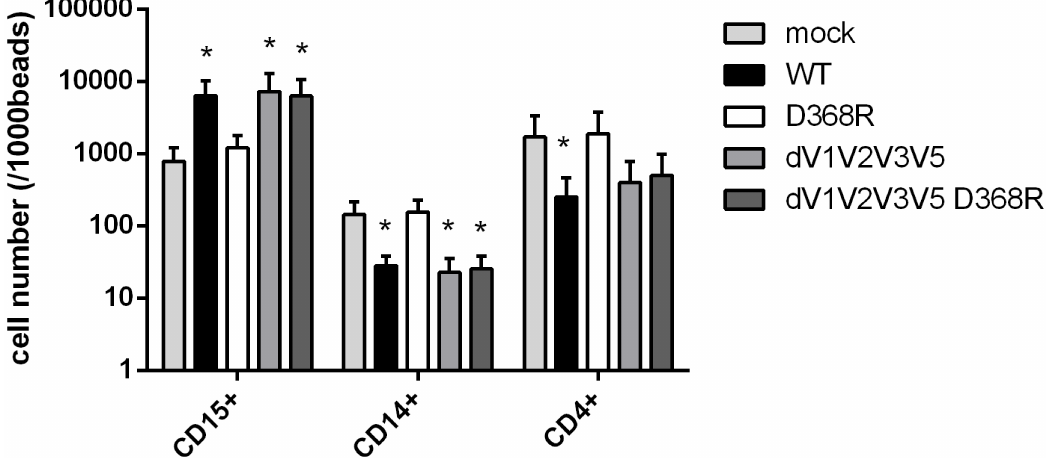
Fig 4. gp120 induces neutrophils and lymphocytes migration but inhibits monocytes migration. Transwell immune cells migrationanalyzedwith evaluationof PBMC subpopulation counts by flow cytometry. 2 * 10^5cells were incubatedwith gp120mutants and then culturedin insert with a 3 μ m membrane. Active migrationof cells was evaluated after harvest of the medium in the wells. Cells were stained with anti CD15, CD14 and CD4 antibodiesand counts were normalized to 1000 beads. Statistic analysiswere performed with variancetest ANOVA and then with a t-tests to compare positive conditions to the mock control ( * p < 0.05and ** p < 0.01).